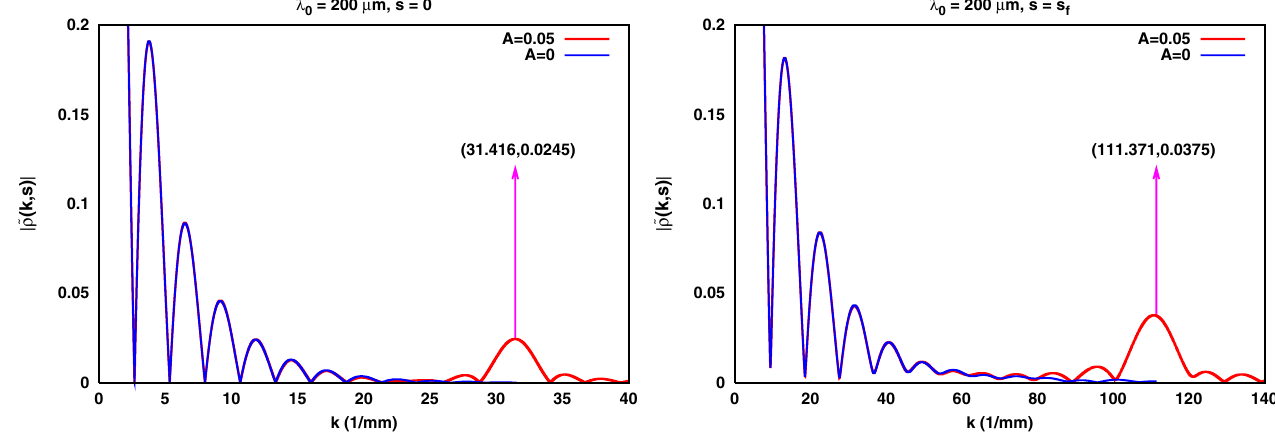
¼ 200 (cid:4) m with and without perturbation at s ¼ 0 (left) and s ¼ s 0